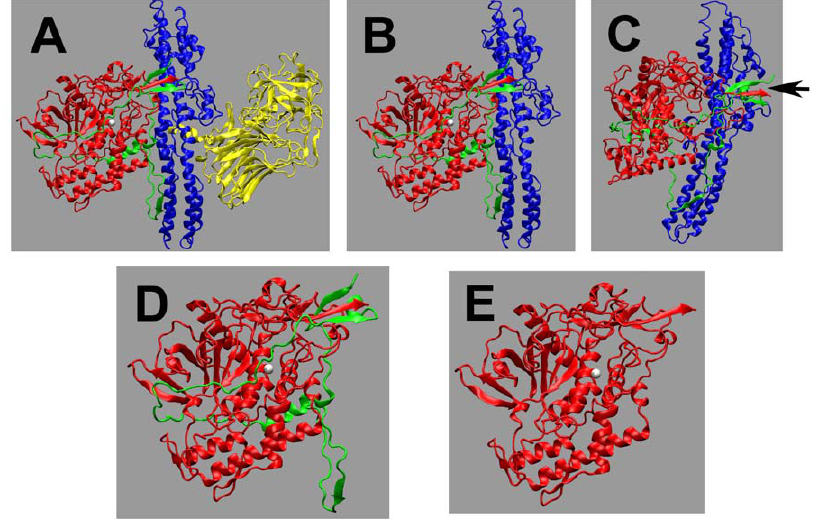
Figure 2. Ribbon diagram of the five versions of the BoNT/A LC used in this study. These diagrams are based on the original 3-dimensional structure of BoNT/A dichain determined by Stevens et al [3]. The constructs used in this study and represented by the structures A, B, and D however are single polypeptide chains. A, Structure of BoNT/A whole toxin. The three major structural domains, the n-terminal LC (red), the central translocation Hn (blue), and the C-terminal binding Hc (yellow) are shown. A stretch of , 115 residues belonging to the translocation domain Hn that wraps around the LC and known as belt, is shown in green. B, LC + Hn; C, LC + Hn that was nicked by trypsin. Here Figure B is slightly rotated to visualize the tryptic cleavge site indicated by an arrow; D, LC + Belt, and E, LC. Although LC and Hn are shown separated in C to distinguish it from B, these domains are in fact still connected by a disulfide bond (see Figure 1) in addition to other ionic and hydrophobic interactions. Figures B–E were generated by simple truncations from the C-terminus of A.